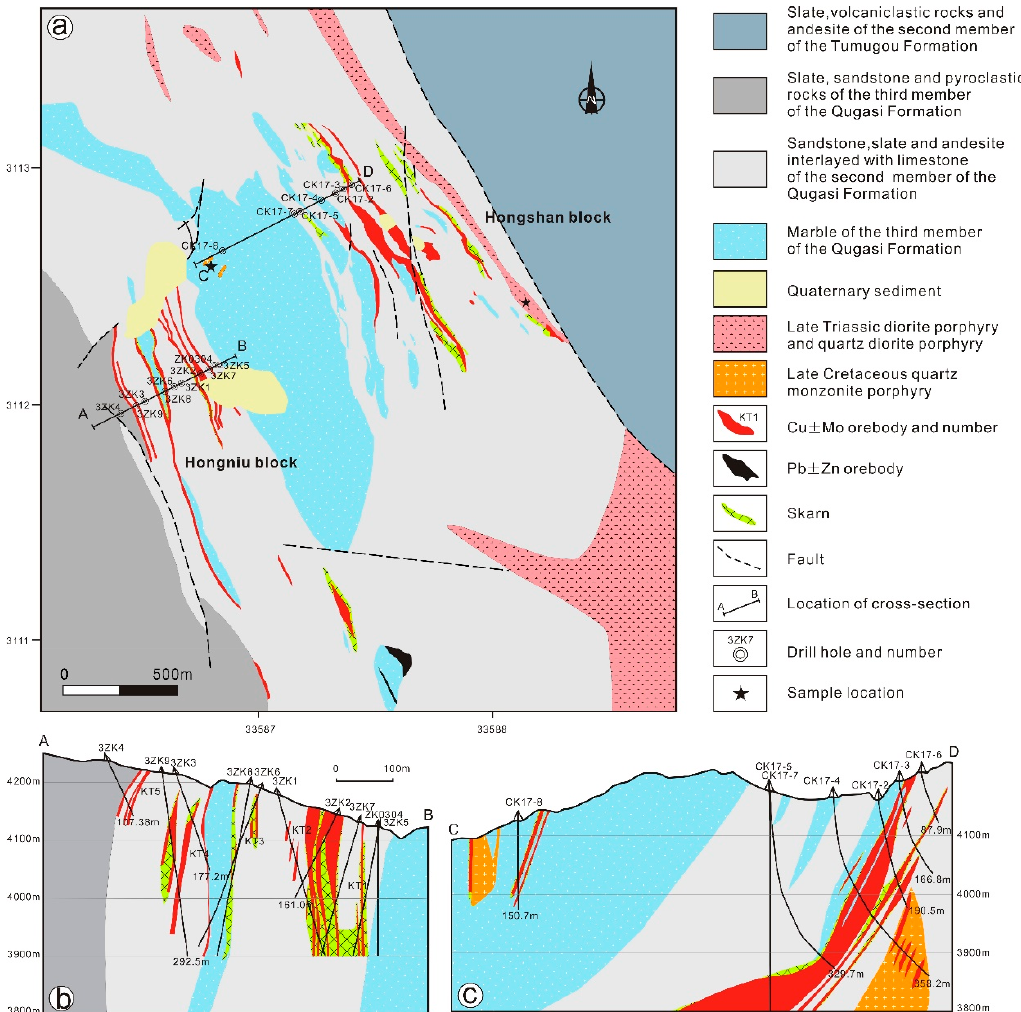
Figure 2. Simplified geological map ( a ) and cross-sections ( b , c ) of the Hongshan Cu–Mo deposit. Modified from Wang et al. [23].